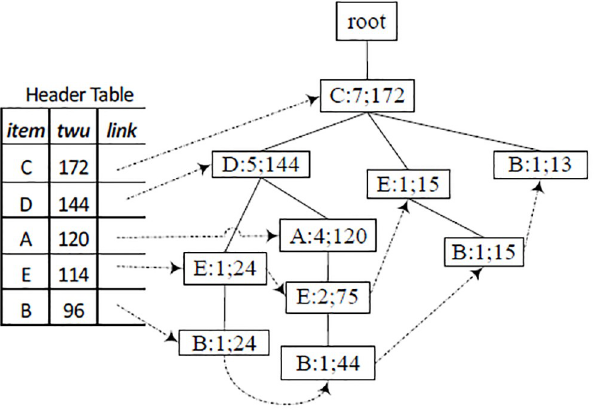
Fig 5. IHUP-Tree [16] based on toy data in Tables 1 and 2 ( η = 70).